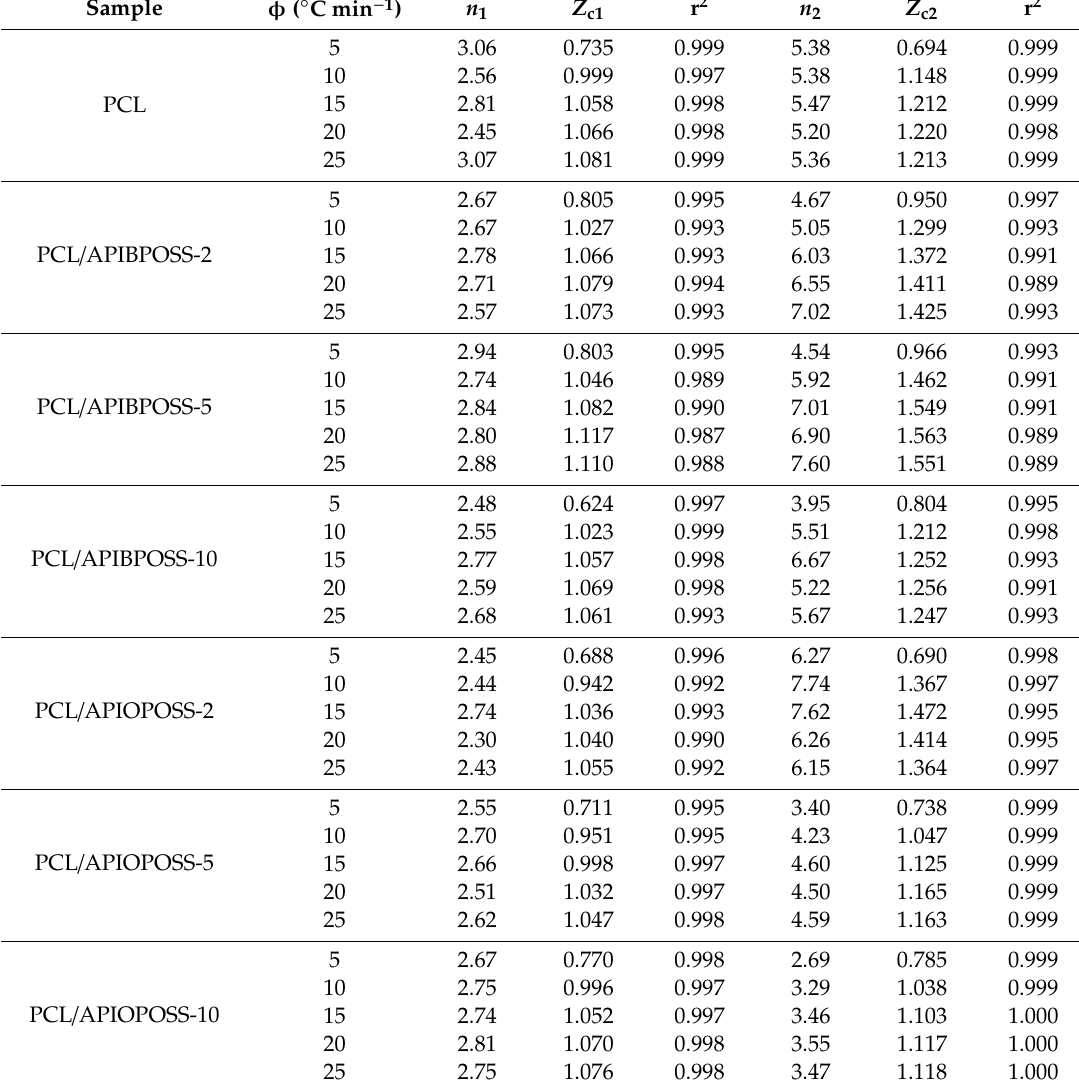
Table 2. Non-isothermal crystallization kinetics based on Avrami analysis for PCL and PCL / POSS